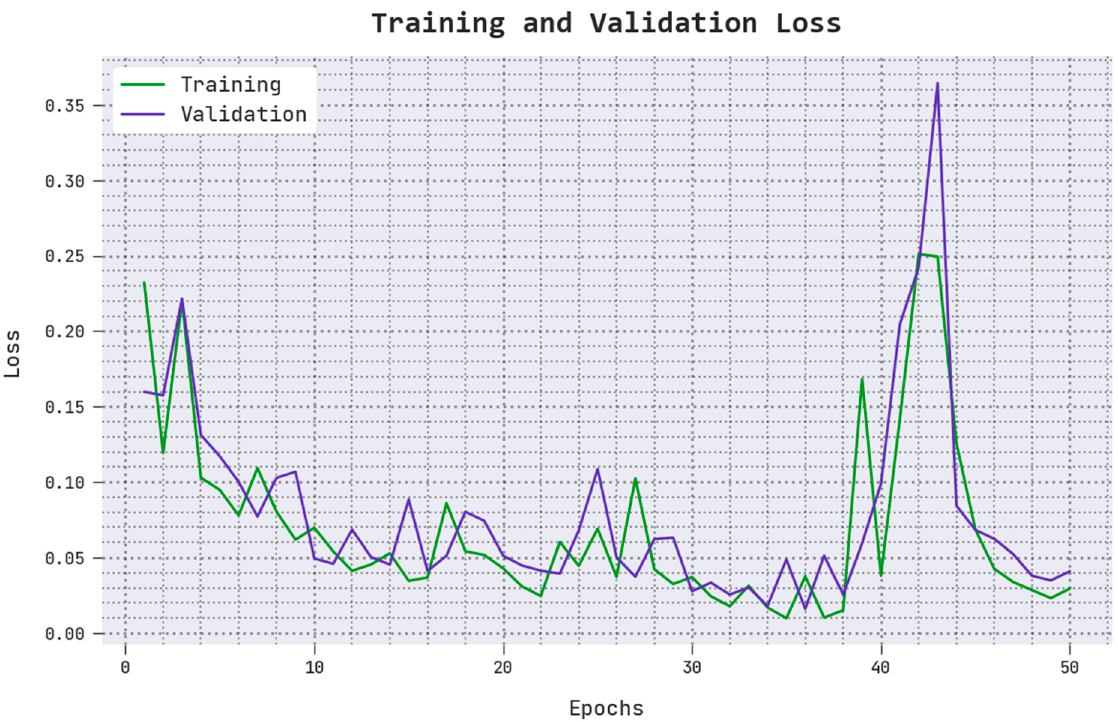
Figure 7. TLS and VLS analytical results of the proposed AOADLB-P2C system.